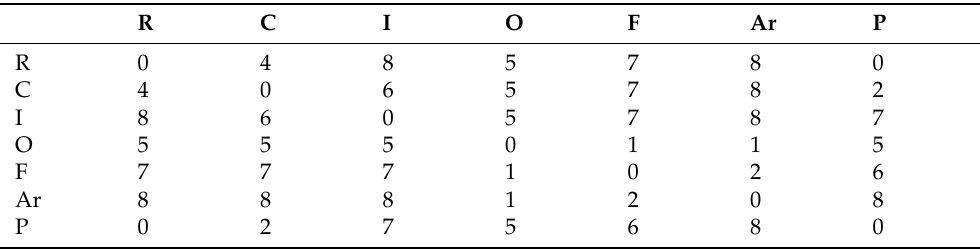
Table 3. Conflict degree between different land uses. The matrix is symmetrical so that conflict degree does not depend on the horizontal directionality of the spatial juxtaposition. Land-use type abbreviations are as per Table 1.